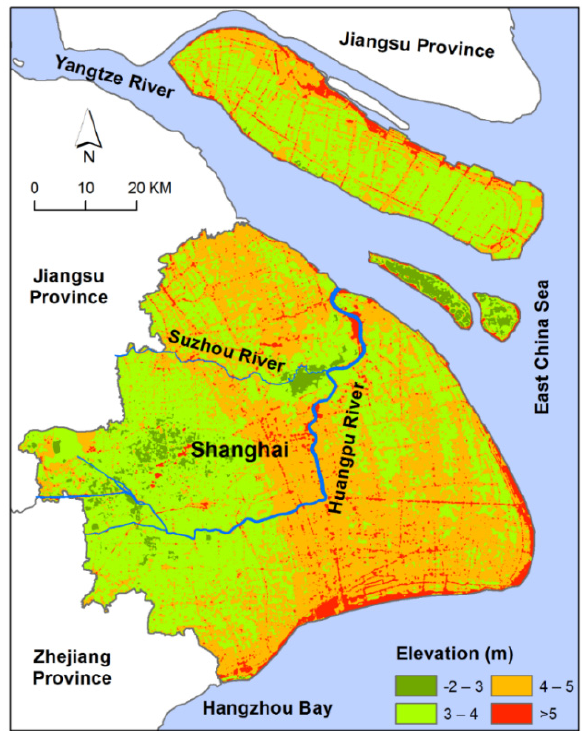
Figure 1. Location, rivers, and elevation of